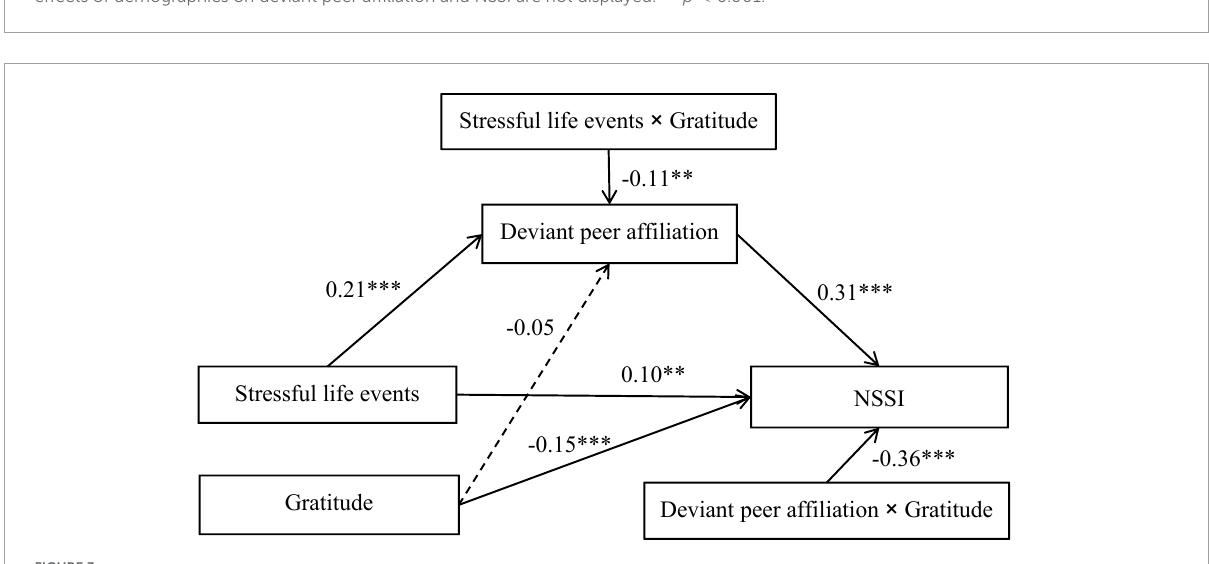
FIGURE3 Model of the moderating role of gratitude on the indirect relationship between stressful life events and NSSI. NSSI, non-suicidal self-injury. For simplicity, the effects of demographics on deviant peer affiliation and NSSI are not displayed. ∗∗ p < 0.01. ∗∗∗ p <